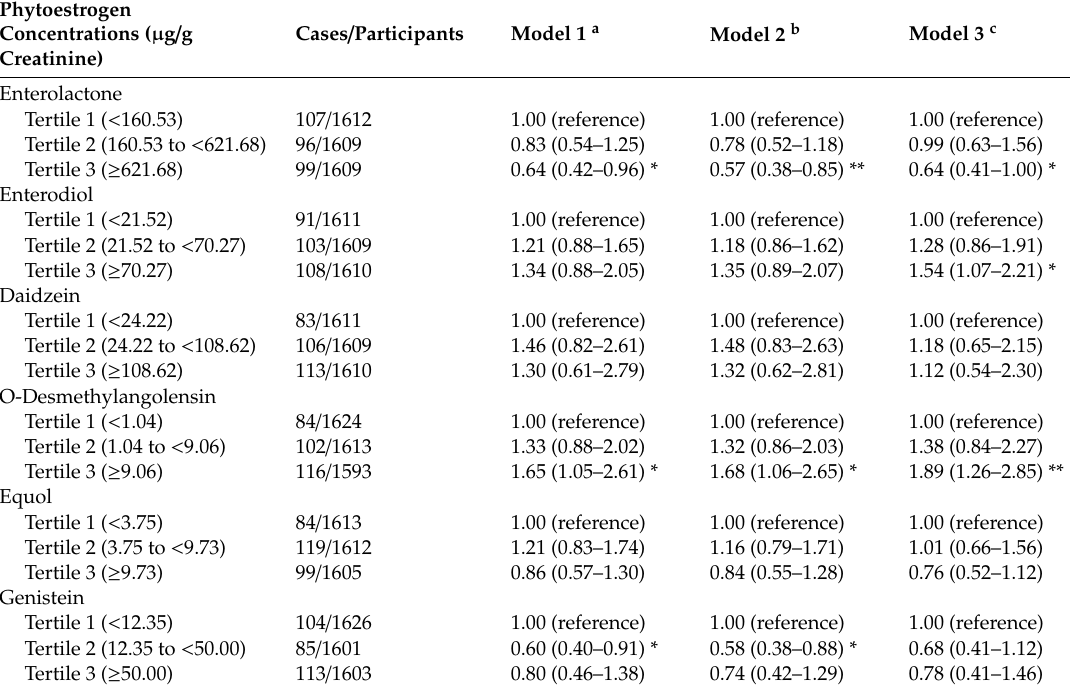
Table 2. Weighted odds ratios (95% confidence intervals) for sleep disorders across tertiles of urinary phytoestrogens concentrations (National Health and Nutrition Examination Survey 2005–2010).